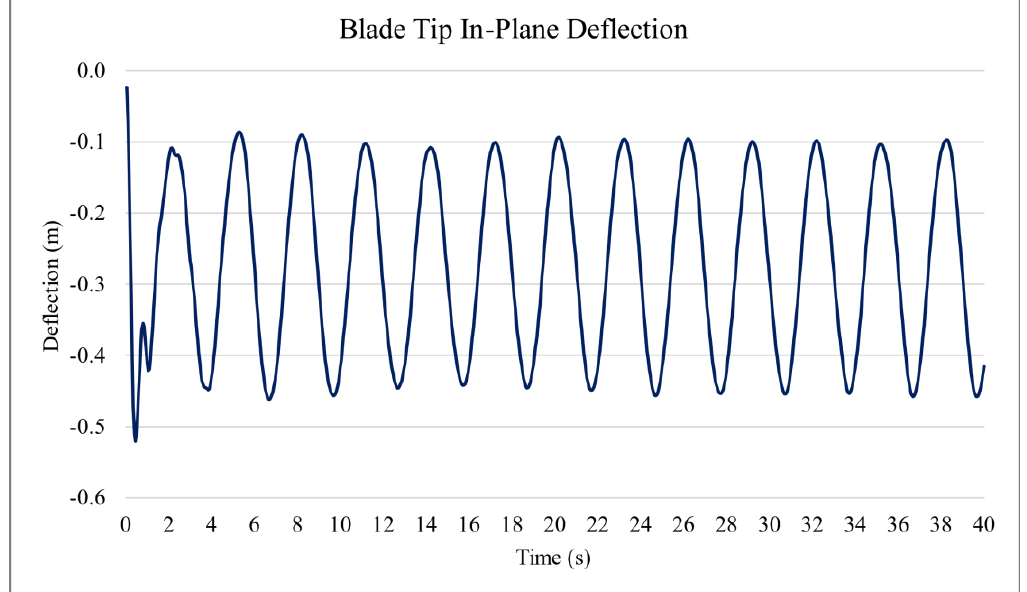
Figure 12. Blade Tip In-Plane Deflection - 1% Turbulence Intensity